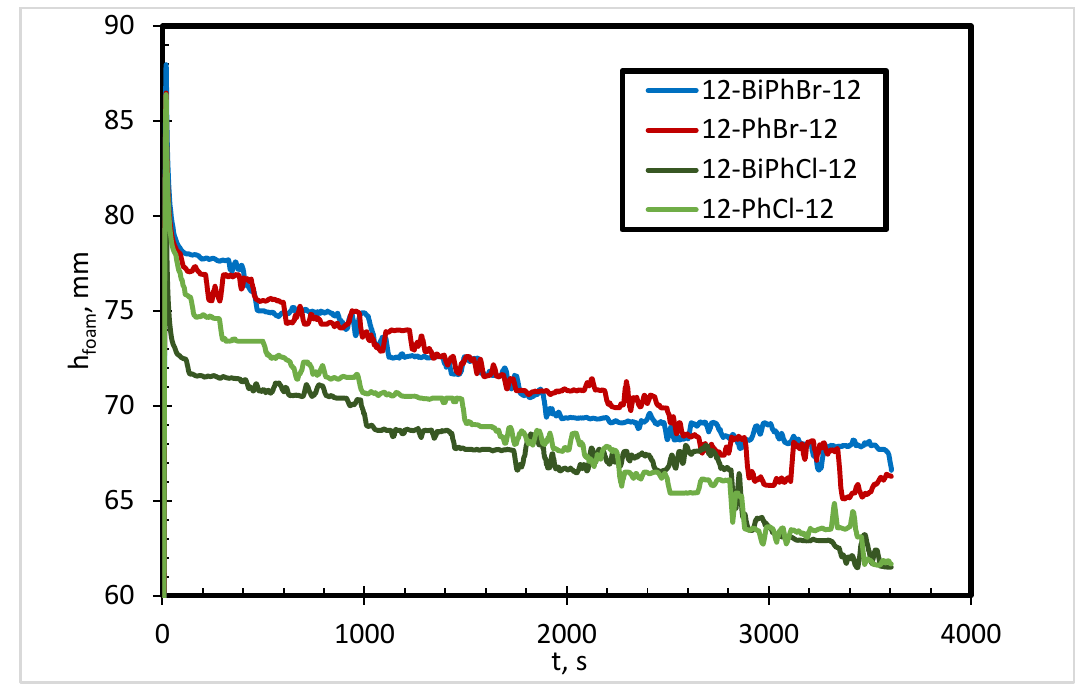
Figure 2. Comparison of foam height of different surfactants.